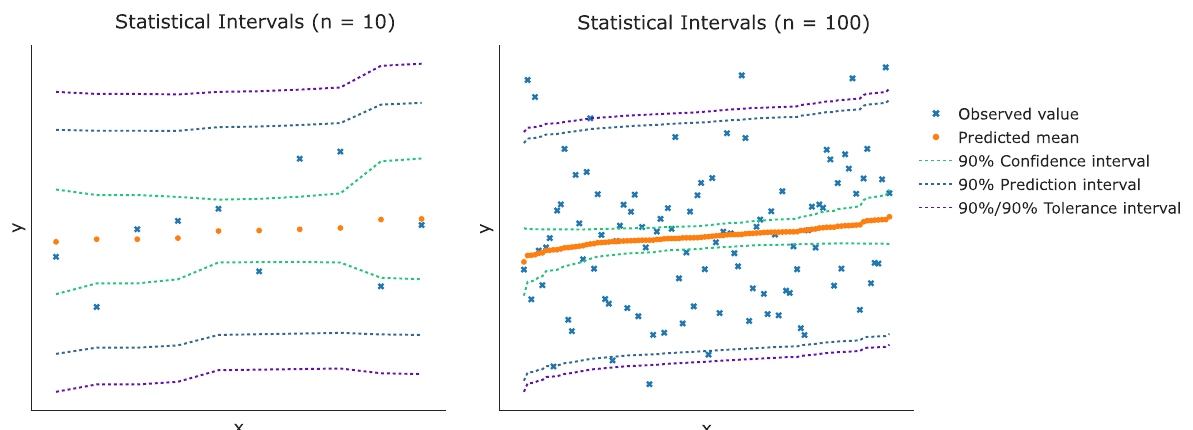
Fig. 2 Comparison of different statistical intervals and sample sizes. For conceptual and mathematical reasons, prediction intervals are always wider than confidence intervals when the same confidence level is assumed. Note that the tolerance interval converges to a prediction interval as the degrees of freedom are